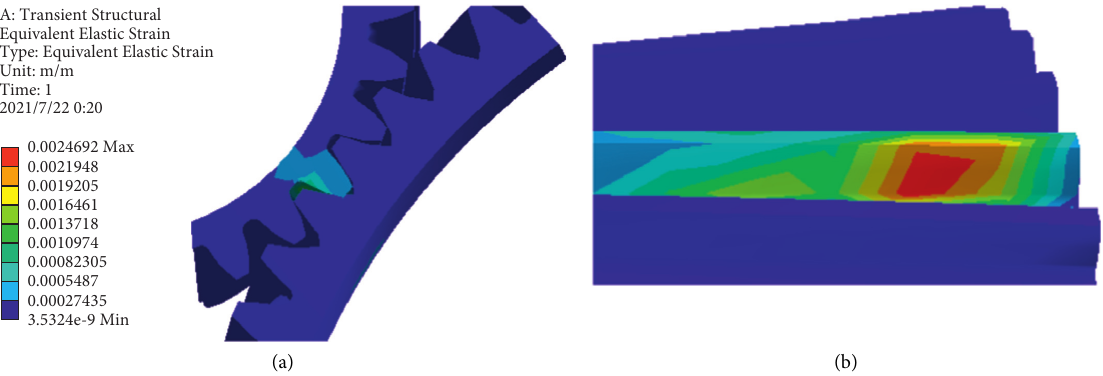
Figure 19: Equivalent strain program of the helical gear group. (a) Equivalent strain program. (b) Strain program of helical gear.